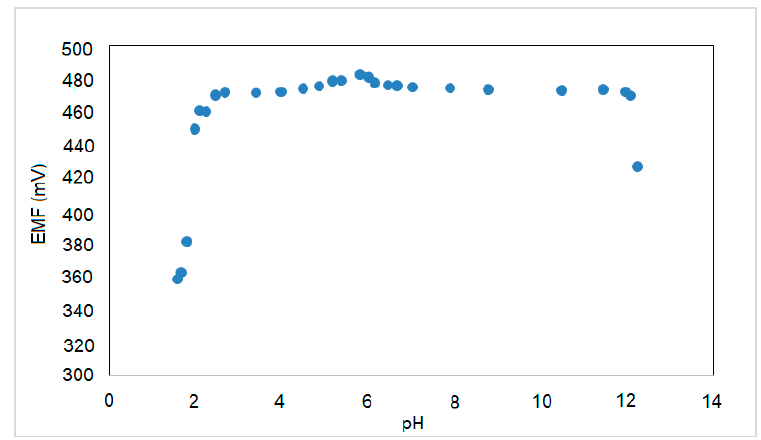
Figure 9. The pH function of iodide-selective sensor.